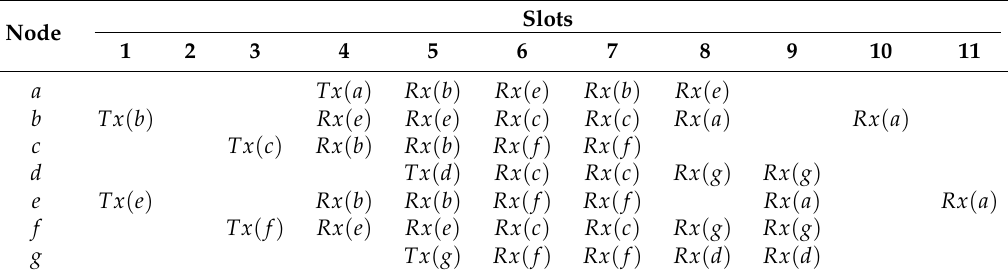
Table 3. Node/Slot allocation for transmission/reception of